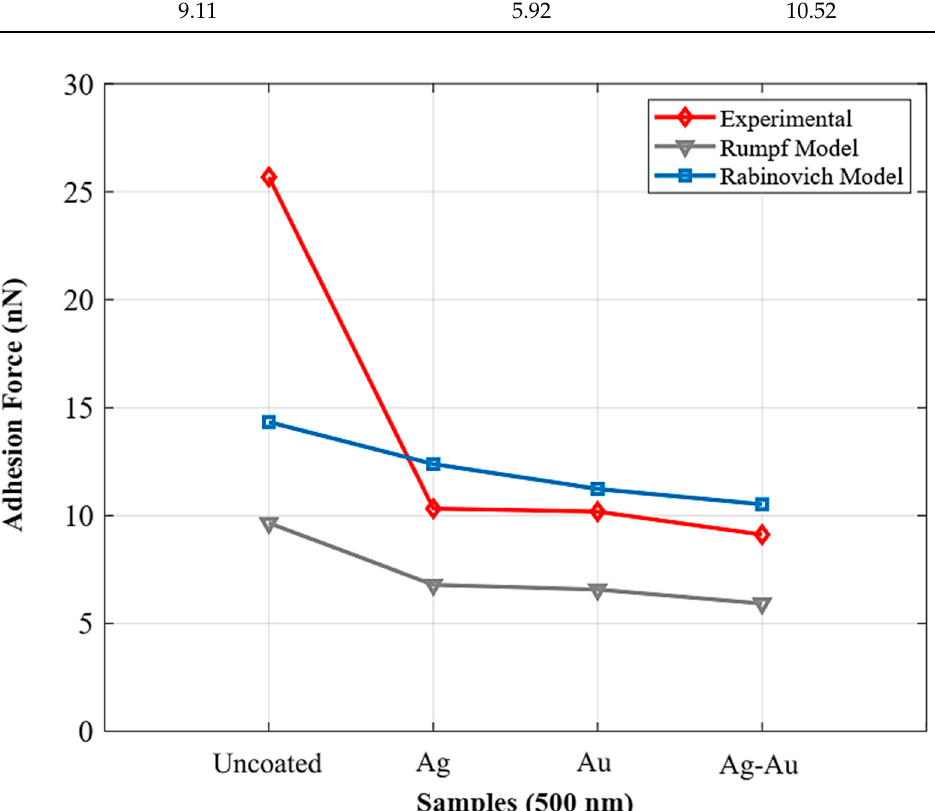
Figure 9. Comparison of adhesion force values between theoretical and experimental approaches to samples with 120 nm thickness.